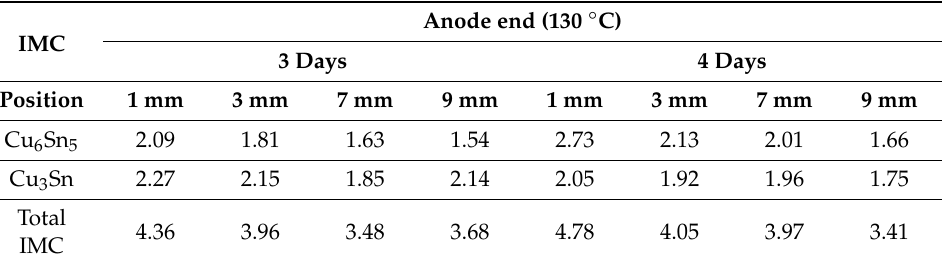
Table 5. The IMC formation and their corresponding thickness in the anode end of the sample heated at 130 ◦ C and subjected to a current of 0.8 A.